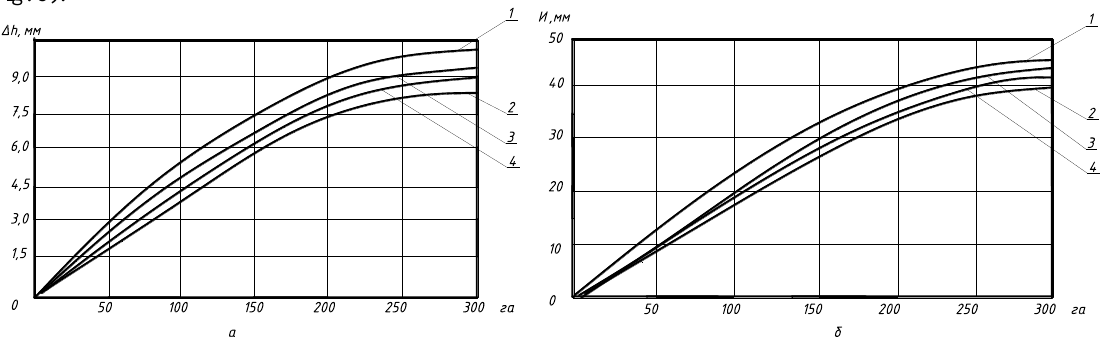
Fig. 5. Changes in wear of width (a) and sock (b) of a plow ploughshare depending on the operating time: 1 - new plowshares made of 65G steel, 2 - restored by welding tires made of steel 45 with sormite surfacing and vibration hardening, 3 - new plowshares made of L-53 steel, subjected to vibration hardening; 4 - new plowshares made of 65G steel, subjected to vibration